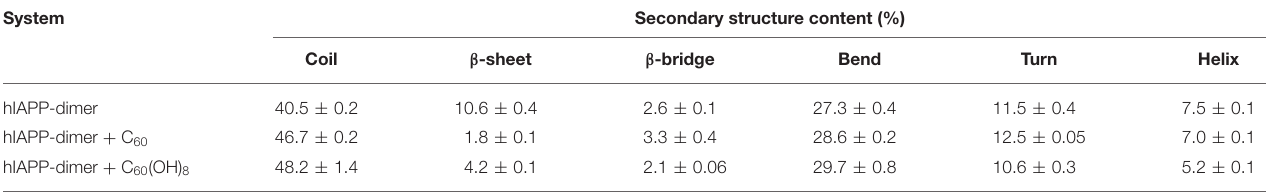
TABLE 1 | Secondary structure probabilities of hIAPP dimer in the absence or presence of carbon